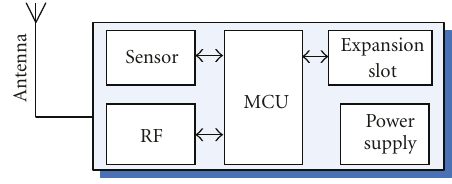
Figure 4: Typical architecture of sensor node.